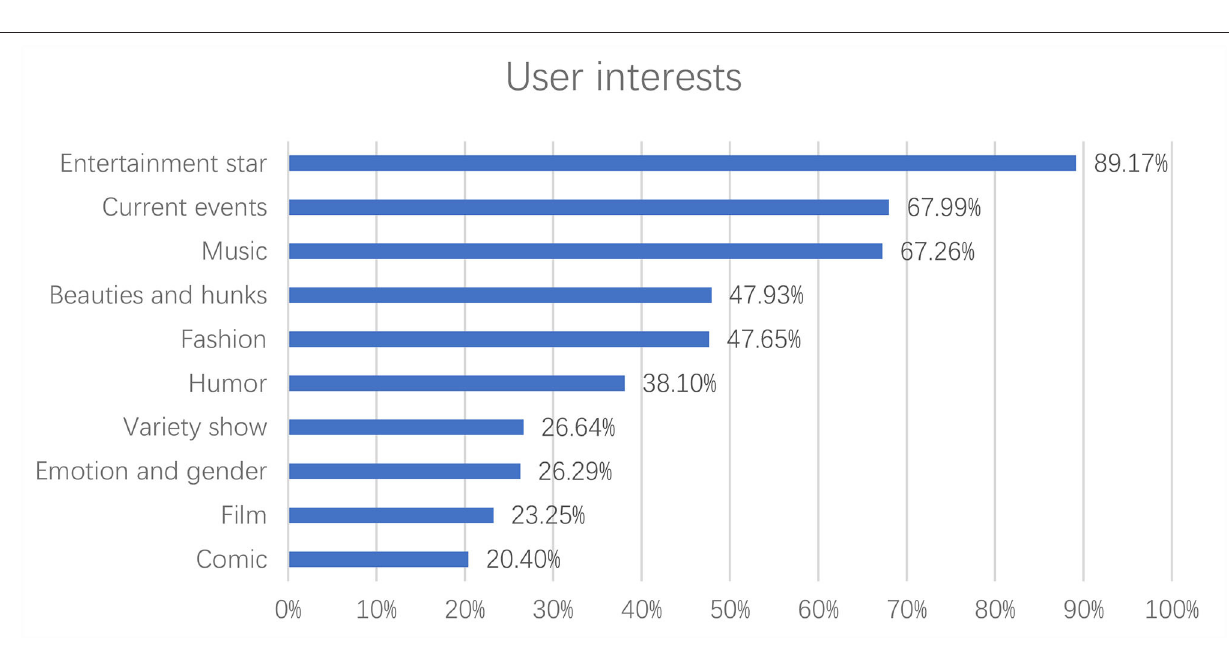
FIGURE 7 | User interests of the hashtag “#national mask campaign#”